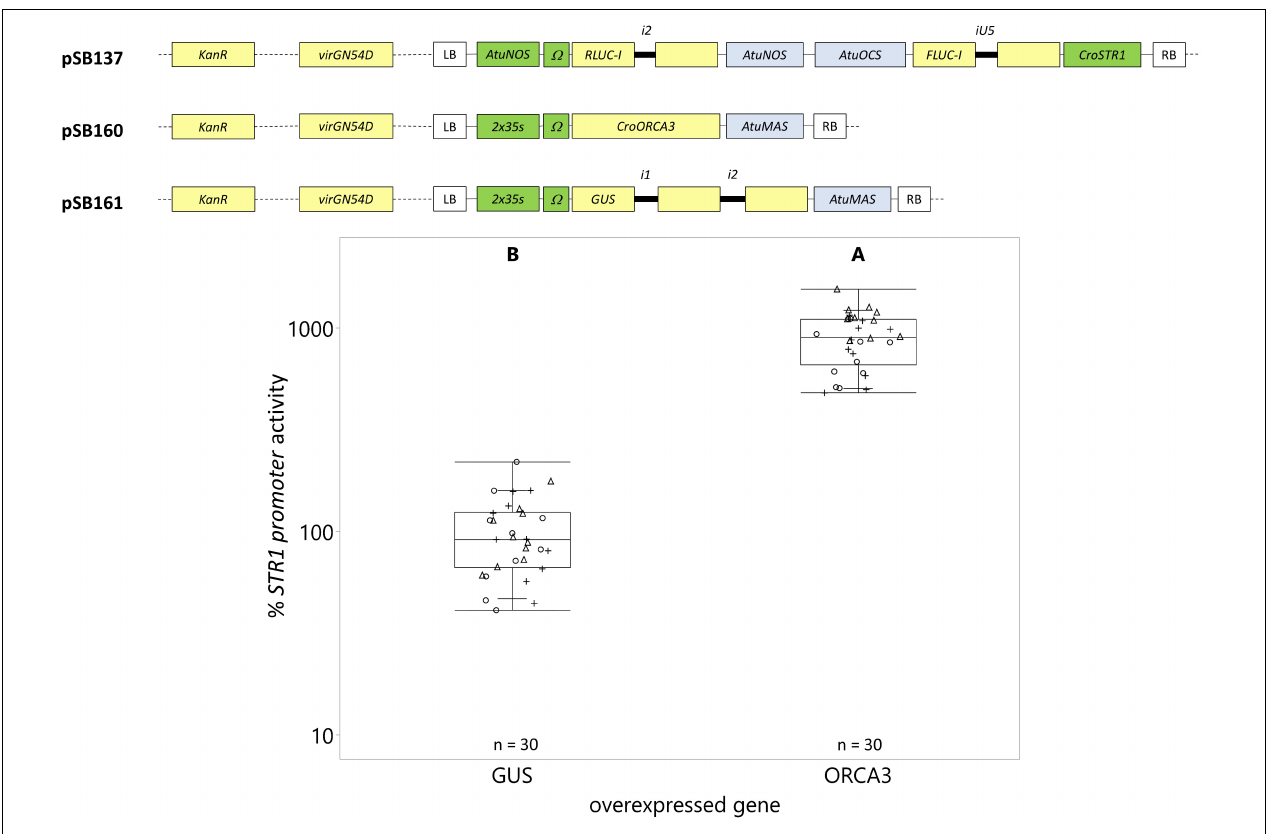
FIGURE 8 | Transactivation of the CroSTR1 promoter with ORCA3. C. roseus seedlings (10-days-old) were vacuum infiltrated with a combination of two strains of A. tumefaciens (1:1 volume ratio): (I) strain containing the CroSTR1 promoter driven FLUC-I reporter and the AtuNOS promoter driven RLUC-I normalization reporter (plasmid pSB137) at OD 600 = 0.2, and (II) strain containing a CaMV2x35s driven gene for transactivation (GUS as control – pSB161 or ORCA3 – pSB160) at OD 600 = 0.2. Samples were taken 3 dpi. The CroSTR1 promoter activity is the FLUC to RLUC activity ratio for each sample normalized to the FLUC to RLUC activity ratio of the GUS control (set to 100%). The experiment was carried out in three independent assays (represented by the + , (cid:13) , (cid:49) symbols). The box plot horizontal line shows the median, ends of the boxes show interquartile range, small marks show the 10th and 90th quantile, and whiskers show lowest/highest data point. Different letters indicate significantly different values. ORCA3 overexpression significantly increased the expression of the STR1 promoter (Student’s t -test on log-transformed data, p <